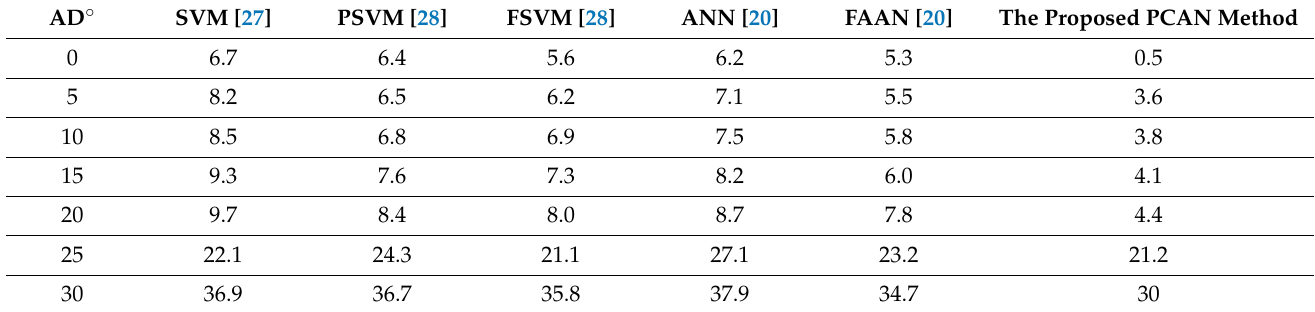
Table 6. MSE rates (%) of the support vector machine (SVM), combination of PCA and SVM (PSVM), combination of Fisher Linear Discriminant (FLD) and SVM (FSVM), artificial neural network (ANN), FLD-ANN (FAAN) and PCA–ANN (PCAN) methods using the used